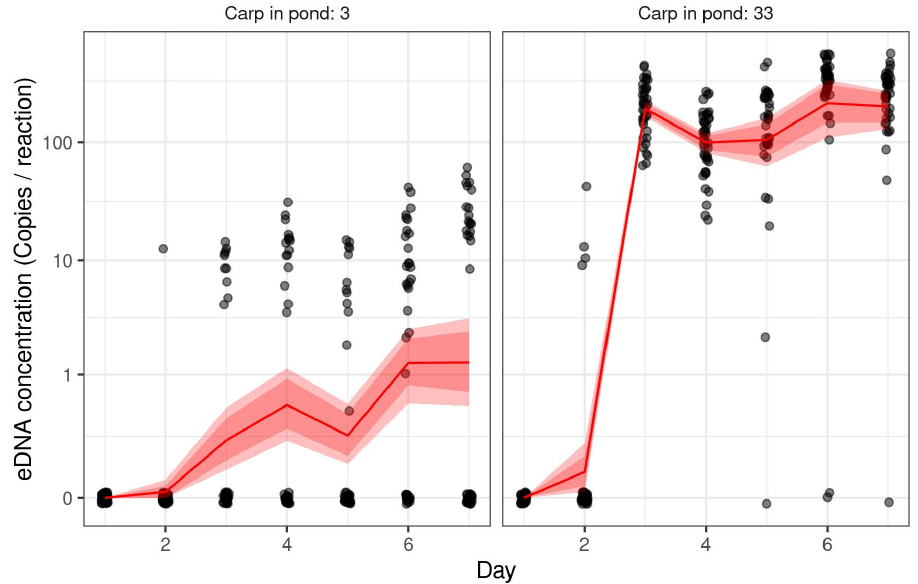
Figure 3. Probability of capturing Grass Carp eDNA in a sample over time. The probability of capturing target eDNA in a sample over time is modeled for each pond using occupancy modeling with results from the LAMP or qPCR detections treated as multiple observers. The 80% credible interval is shown with dark shading and the 95% credible interval is shown with light shading. Square points represent individual samples jittered around 0 (did not capture target eDNA) or 1 (did capture target eDNA).